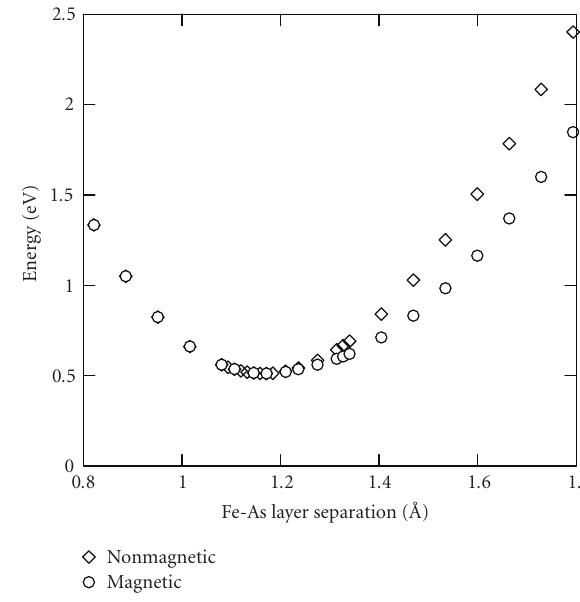
Figure 2: Dependence of the experimentally determined magnetic moment on the Fe-As layer separation for CeFe(As,P)O (open circles) [28], and the fit by (3) (solid curve).